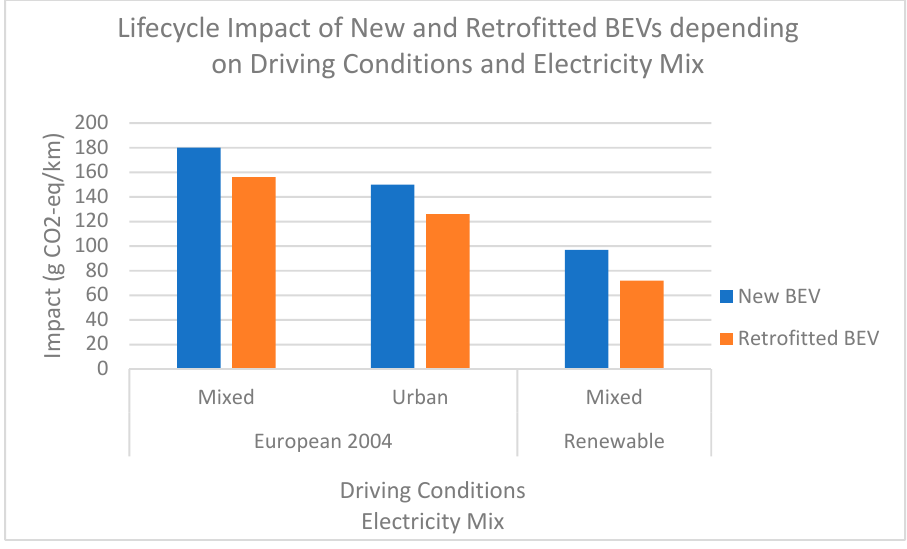
Figure 6. Graph showing the lifecycle impact of new and retrofitted BEVs [86].